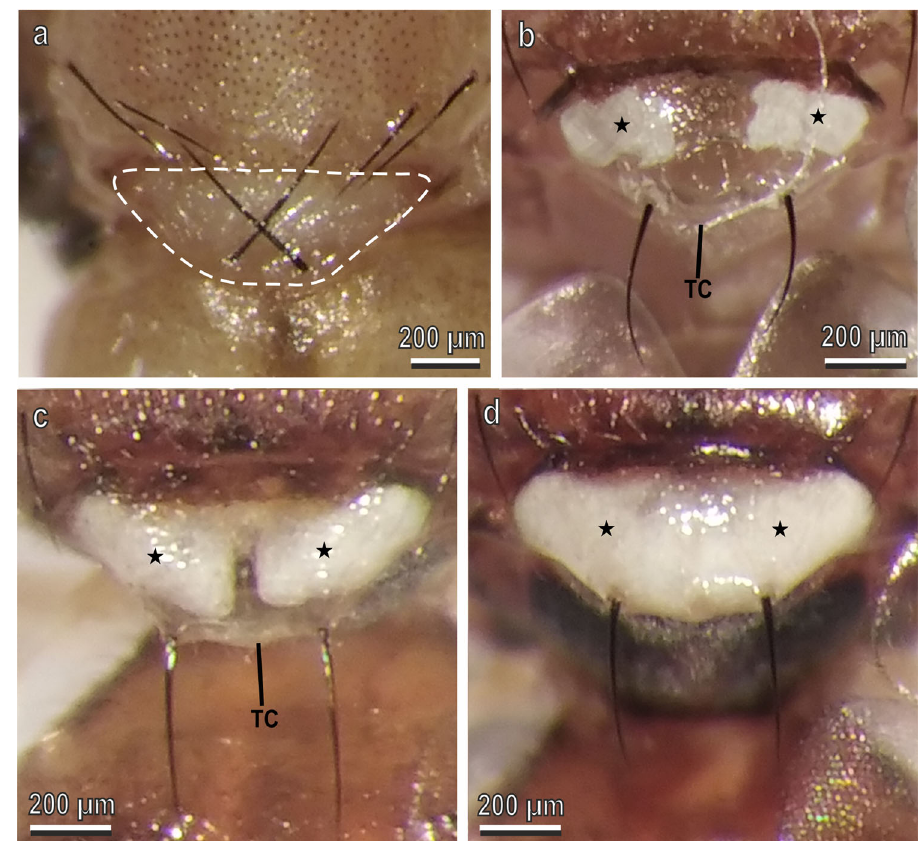
Fig. 2 Dorsal view of the scutellum of Bactrocera oleae under stereomicroscope. a Scutellum (dotted line) in the pharate adult without any white coloration; b , c Scutellum in the just emerged adult ( b ) and in the adult six hours after emergence ( c ) with transparent cuticle (TC) under which two separated reduced white areas are visible (stars), corresponding to the two air sacs; d Scutellum in the adult 24 h after emergence with transparent cuticle, under which two fully developed air sacs (stars) are present, giving it a uniform bright white